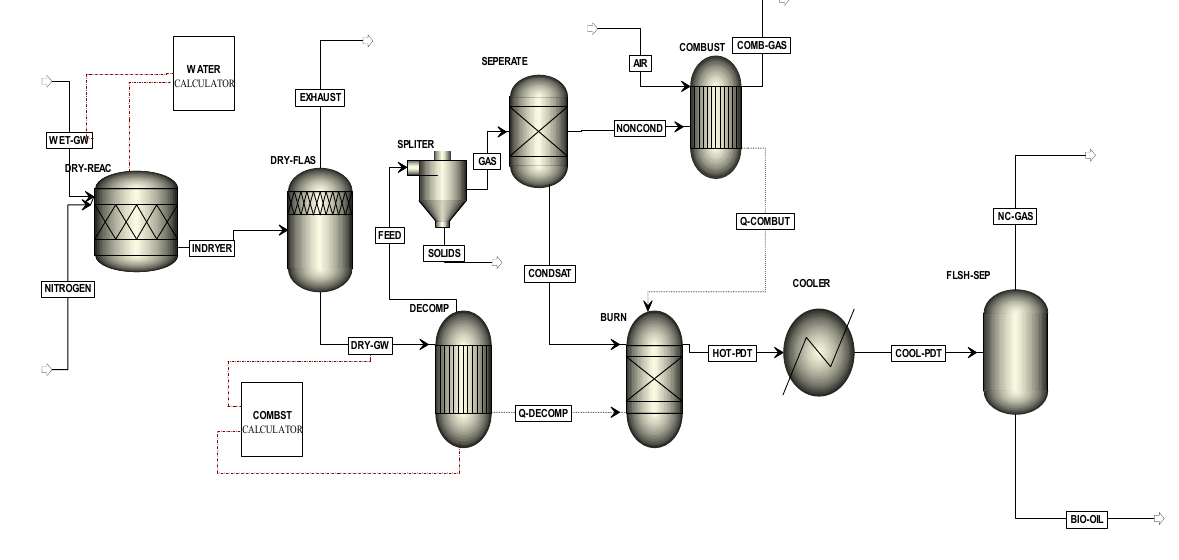
Figure 5. Aspen Plus model flowsheet of MGW